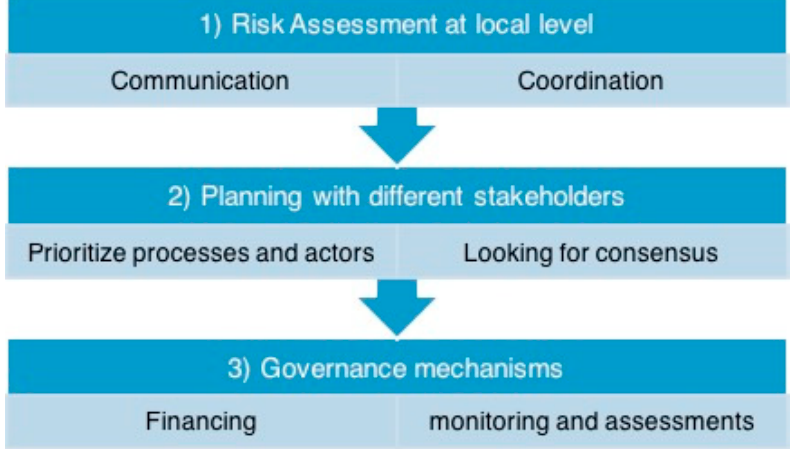
Figure 6. Schematic model of a hazard management.